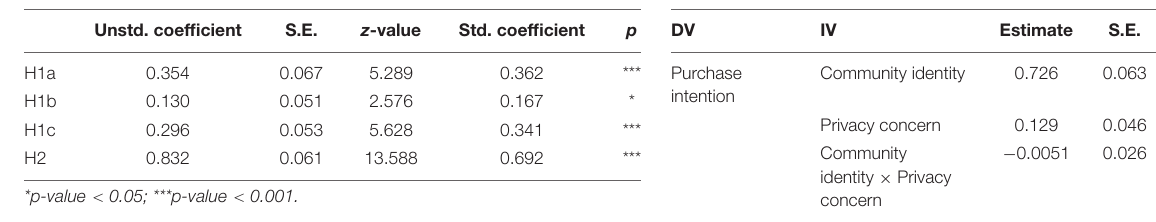
TABLE 7 | The analysis of moderation